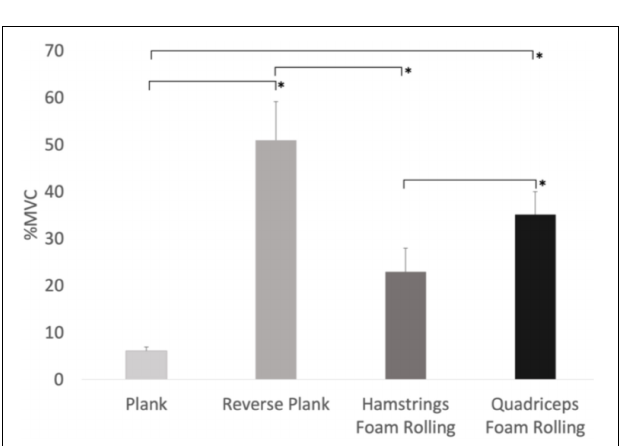
FIGURE 5 | Main effect for conditions with the upper lumbar erector spinae EMG activity. ∗ Significant difference between the conditions ( p < 0.05), %MVIC refers to